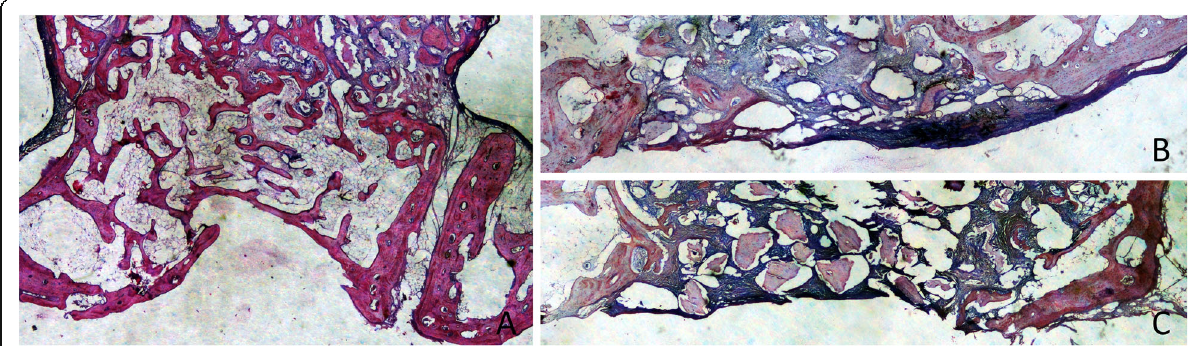
Fig. 6 Photomicrographs of decalcified sections illustrating the healing after 8 weeks. a Treated site. Most of the antrostomies presented remaining defects in the outer contour. b , c Untreated sites. Two antrostomies of the treated sites and four of the untreated sites appeared not closed with corticalized bone and presented connective tissue interposed between the edges of the antrostomy. Scarlet-acid fuchsine and toluidine blue stain. a Image grabbed at × 20 magnification. b , c Images grabbed at × 40 magnification